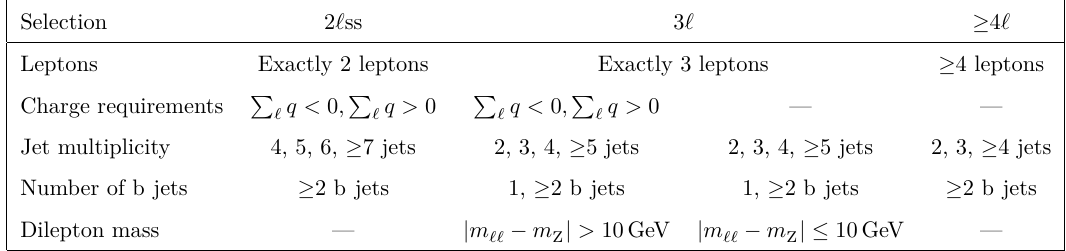
Table 2 . Requirements for the different event categories. Requirements separated by commas indicate a division into subcategories. The b jet requirement on individual jets varies based on the lepton category, as described in the